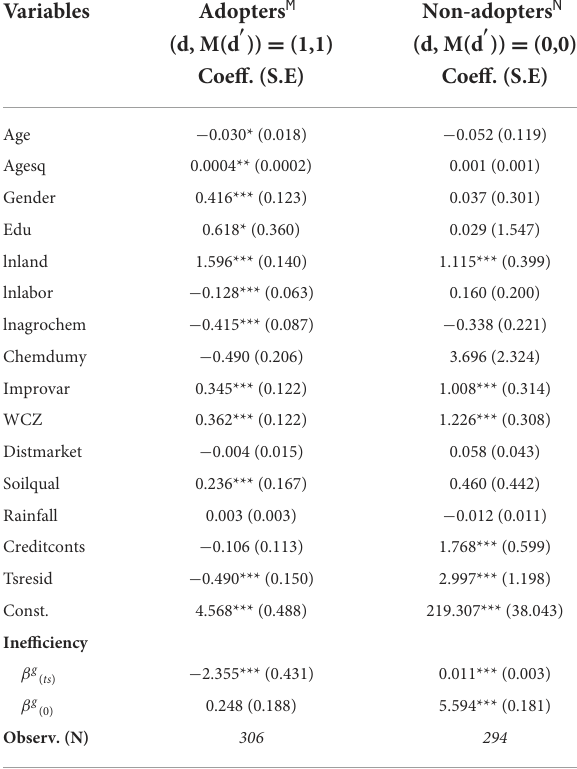
TABLE 2 Adoption with mediation—(weighted nonlinear least-squares)—yield (lnKg/Ha).